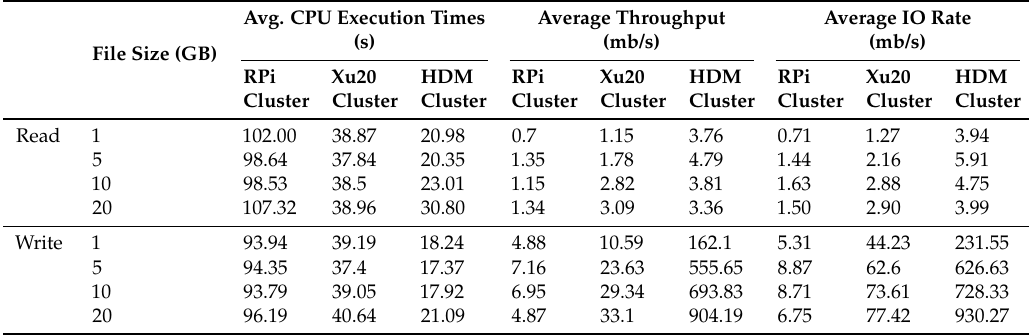
Table 7. CPU execution times, throughput and average IO for TestDFSIO read and write benchmarks on